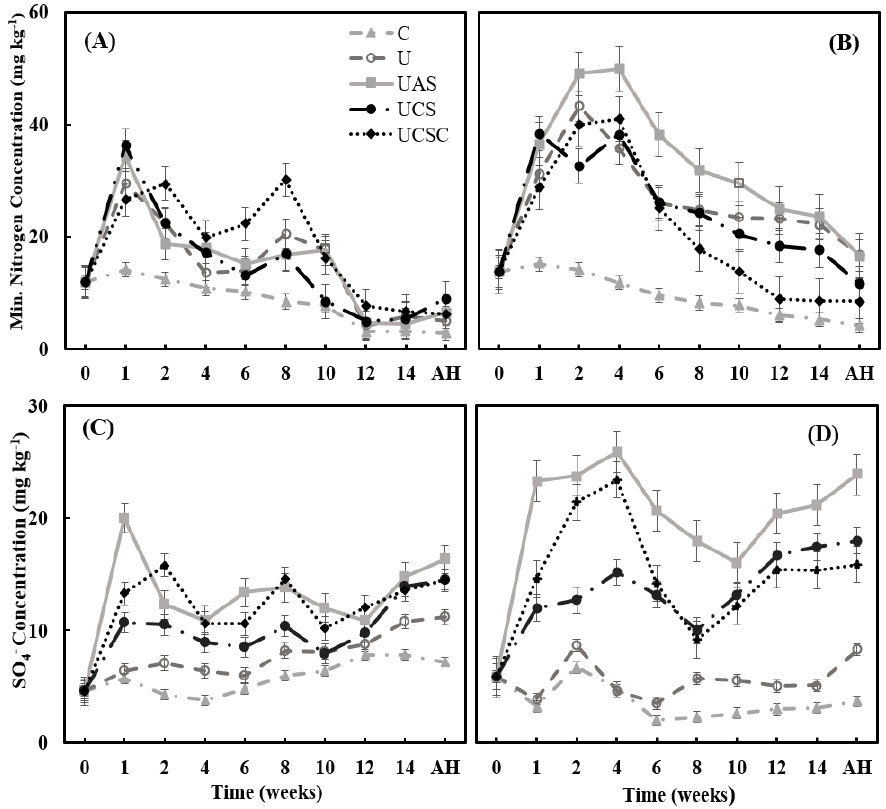
Figure 3. The release of mineral nitrogen ( A , B ) and soil available sulfur ( C , D ) with time from the fertilizer treatments in soil surface layer 0 – 30 cm during the maize growth period and after harvest (AH) in 2018 ( A , C ) and 2019 ( B , D ). C = Control U = Urea, UAS = Urea + ammonium sulfate, UCS = Urea + CaSO 4, and UCSC = Urea cocrystal (CaSO 4 .4urea). ( A ) C r = −0. 964** ; U r = −0. 698*; UAS r = −0. 699* ; UCS r = −0. 704* and UCSC r = −0. 648*; ( B ) C r = −0. 981**; U r = − 0.441; UAS r = −0. 453; UCS r = −0. 611 and UCSC r = −0. 694*; ( C ) C r = 0.843**; U r = 0.927**; UAS r = 0.279; UCS r = 0.670* and UCSC r = 0.380; ( D ) C r = −0. 528; U r = 0.182; UAS r = 0.253; UCS r = 0.759* and UCSC r = 0.034; * Significant differences at p < 0.05; ** Significant differences at p < 0.01.